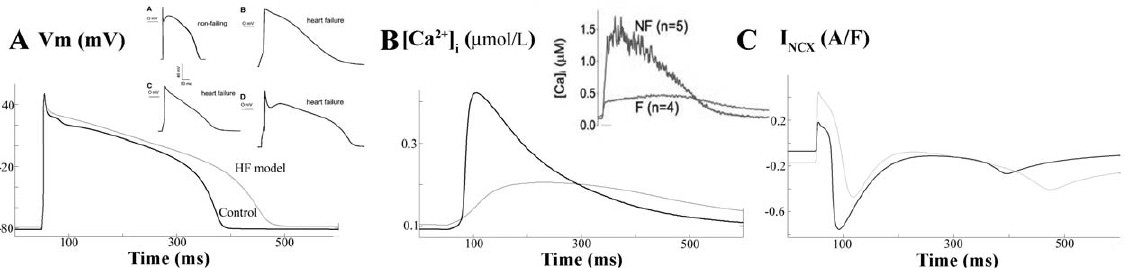
Figure 2. Electrophysiological changes in heart failure. Simulated APs (panel A), [Ca 2 + ] i transients (panel B), and Na + /Ca 2 + exchanger (NCX) activity (panel C) at 1-Hz pacing rate in control (dark line) and in heart failure (HF) conditions (light line). The insets show experimental recordings of Priebe and Beuckelmann et al. [5] (panel A) and Weber et al. [31] (panel B).